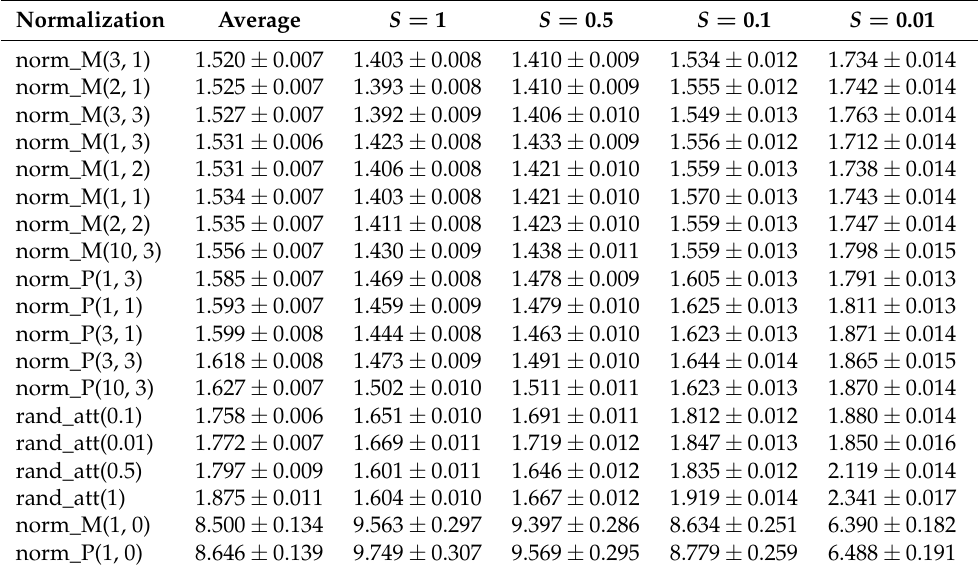
Table A3. Mean mel reconstruction errors on for mel spectrograms rescaled by the factor S . All errors in dB with a 95% confidence